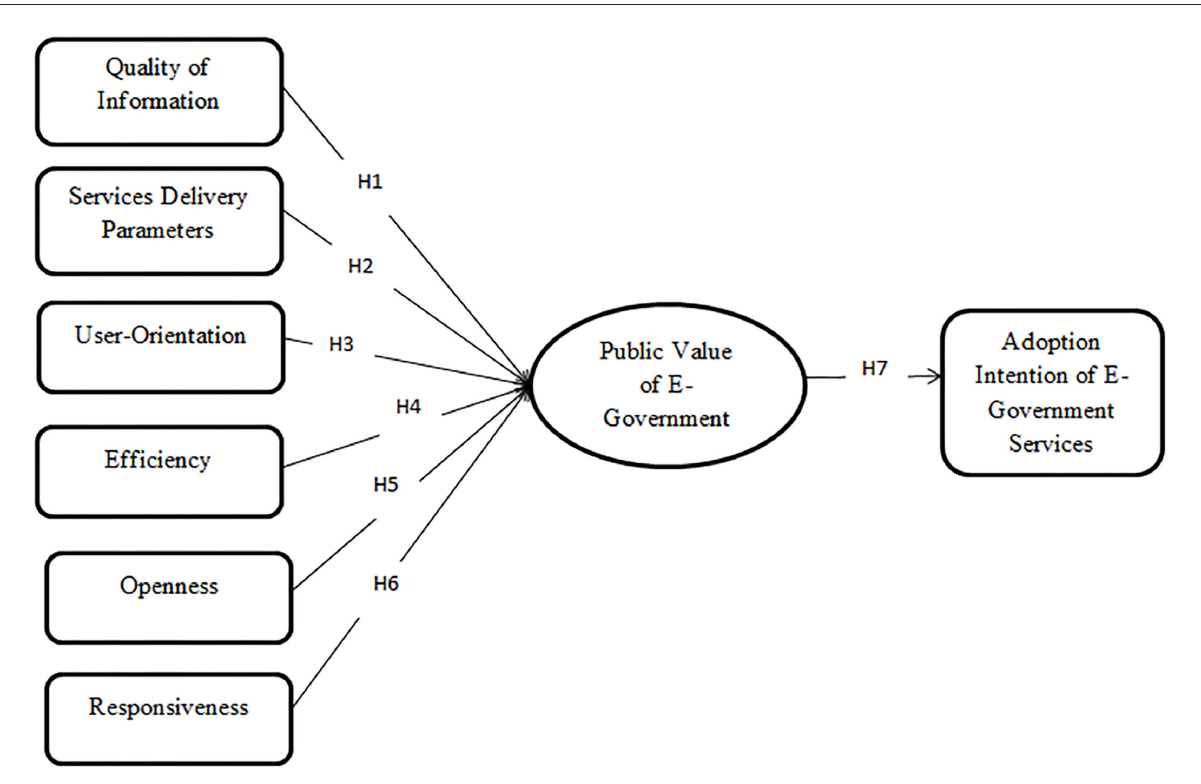
FIGURE3 Proposed public value of e-government adoption model